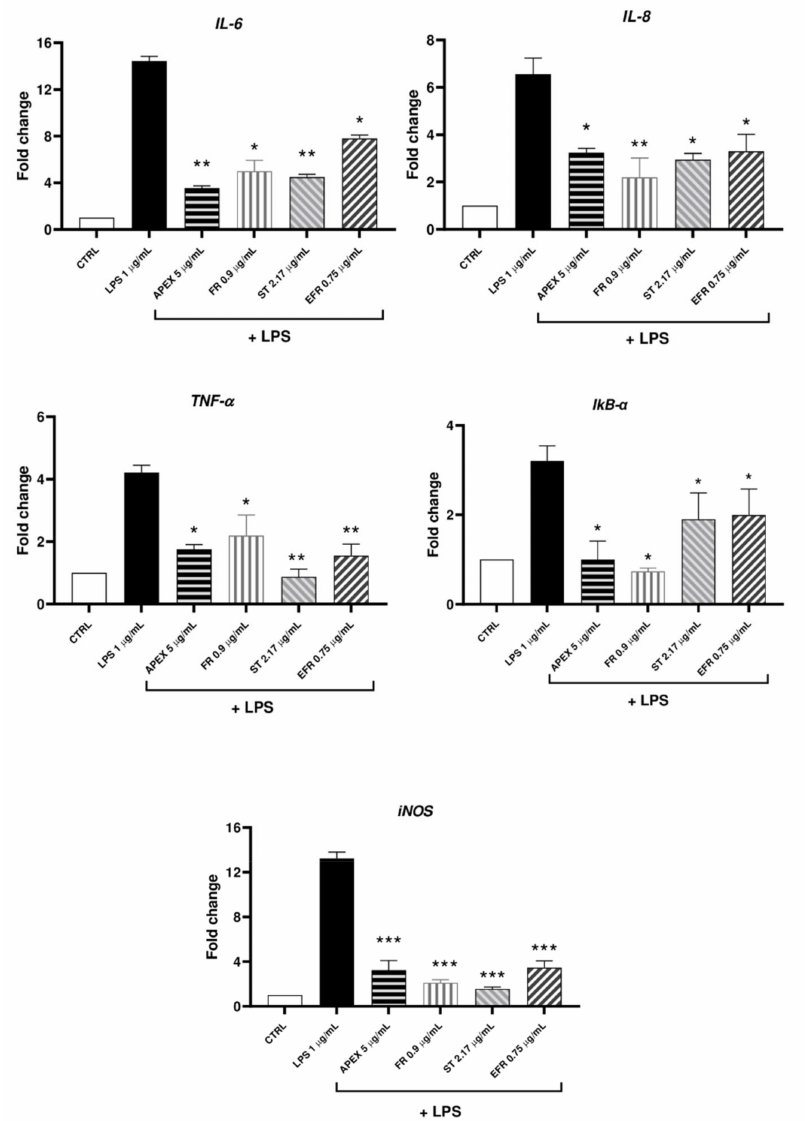
Figure 7. mRNA levels of cytokines and selected inflammation markers ( IL-6, IL-8, TNF-a, IkB-a, iNOS ) in LPS-stimulated U937 cells. Cells were preincubated (24 h) with APEX, FR, ST and EFR and then grown for a further 12 h with LPS (1 µ g/mL); the expression level was determined immediately after treatments. Data are reported as fold increase compared to untreated control cells. Data are the means ± SEM of at least three independent experiments. * p < 0.05, p ** < 0.001, p *** < 0.0001, compared to LPS-stimulated cells (one-way